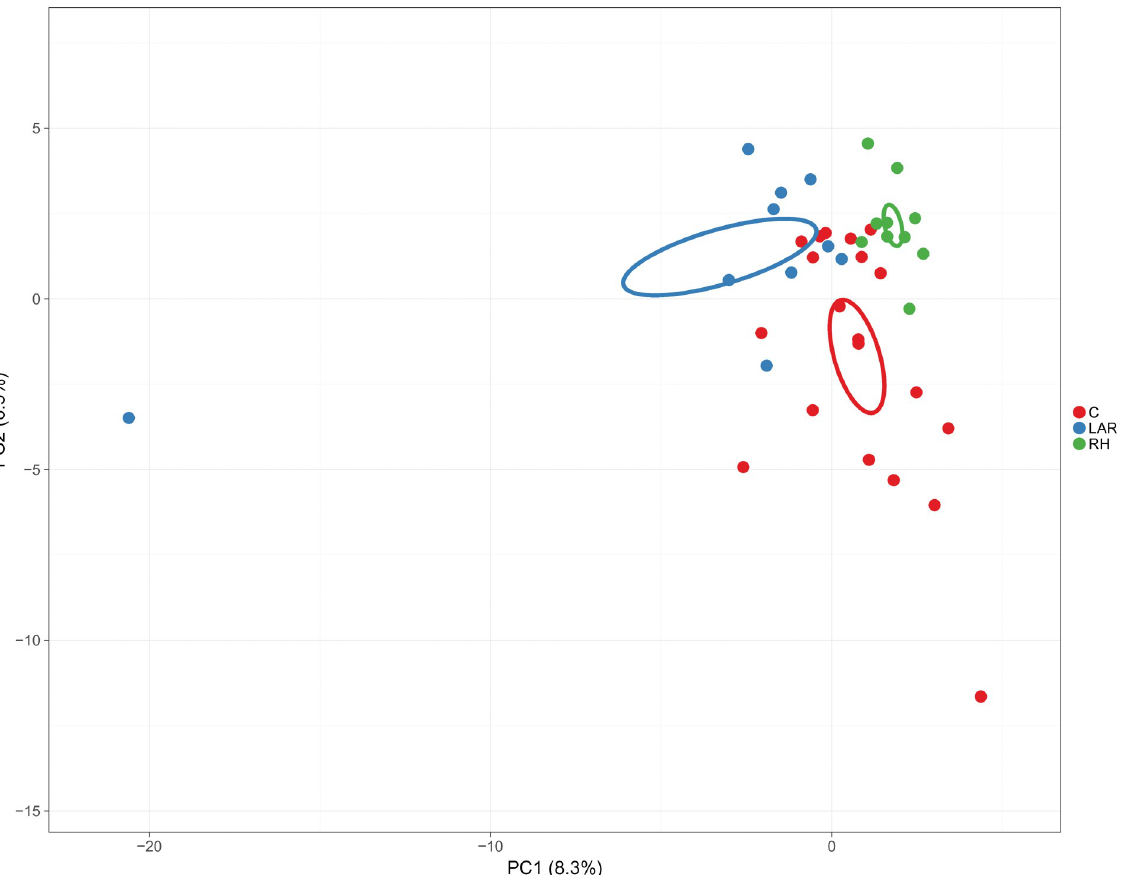
Fig 2. Principal component analysis of bacterial genera abundance. G ut microbial genera composition using a principal component analysis (PCA) of the log-transformed relative abundances showed a clear separation between control group, and those after right hemicolectomy (RH) or low anterior resection (LAR). Compared with control group, RH group and LAR group revealed significant differences in bacterial genera abundance respectively (p all < 0.001, Monte-Carlo